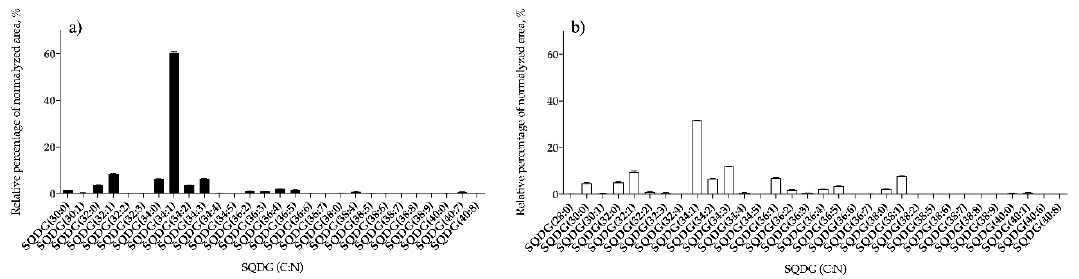
Figure 1. Relative abundance (RA) of lipid species of the sulfoquinovosyl diacylglycerol (SQDG) class identified in B. bifurcata ( a ) and S. muticum ( b ). The results are expressed as relative percentages after dividing the normalized peak area of each lipid species to the sum of normalized peak areas for all the lipid species within the class obtained after LC–MS analysis. Numbers in parentheses (C:N) indicate the number of carbon atoms (C) and double bounds (N) in the fatty acid side chains. The species with higher RA was SQDG (34:1) for both seaweeds.